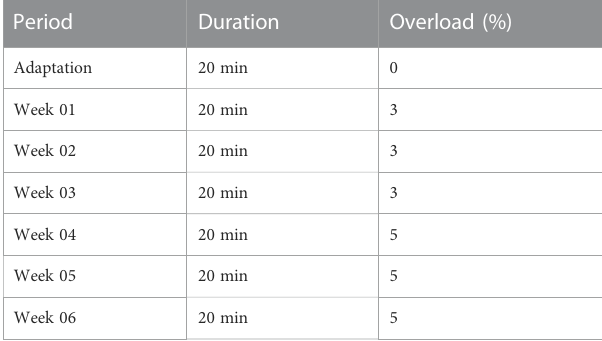
TABLE 2 Moderate swimming exercise